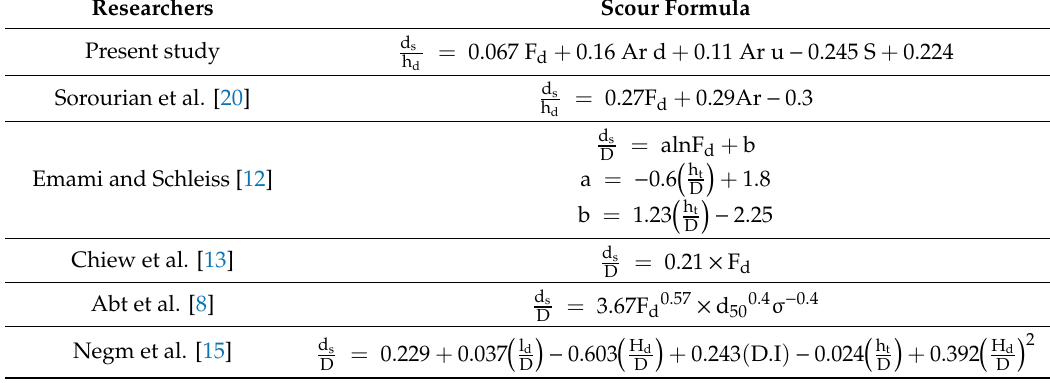
Table 2. Summary of some scour prediction formulas.